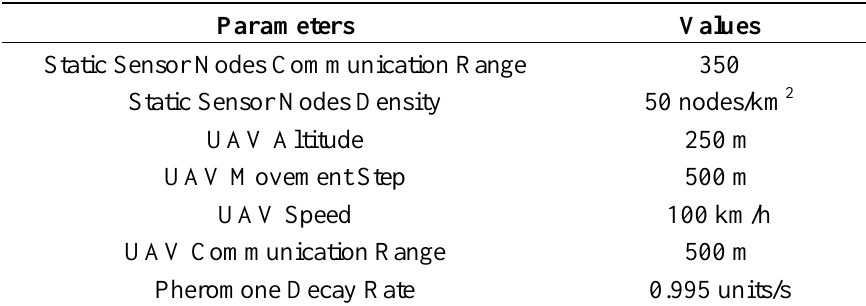
Table 1. Main simulation parameters and